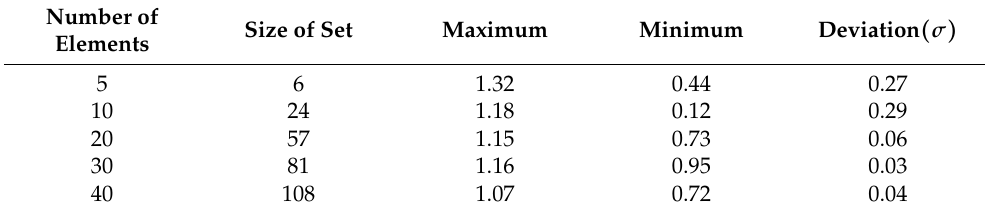
Table 2. Statistical results of weight sets of ALE-RANCF model.